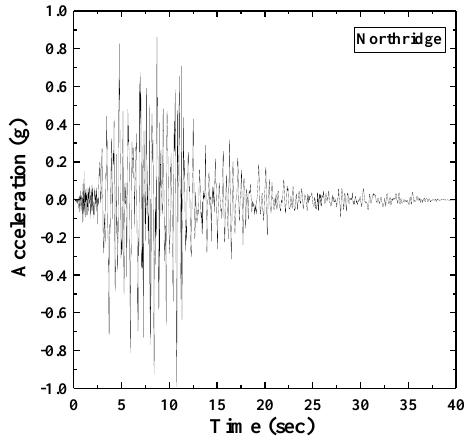
Fig. 2. History of ground acceleration record during the 17 January 1994 Northridge (M w = 6.7) earthquake (COSMOS, 2010).